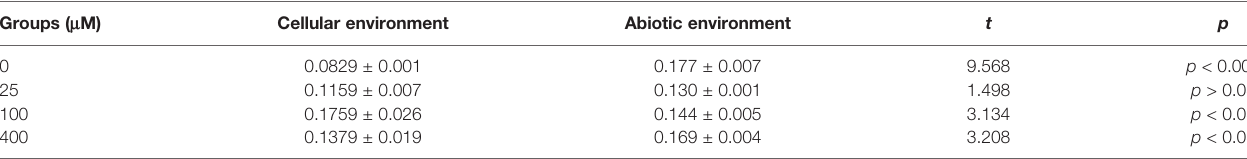
TABLE 3 | Expression of hcp of Acinetobacter baumannii in different culture environments (2 − D Ct , means ± SD). Groups ( m M) Cellular environment